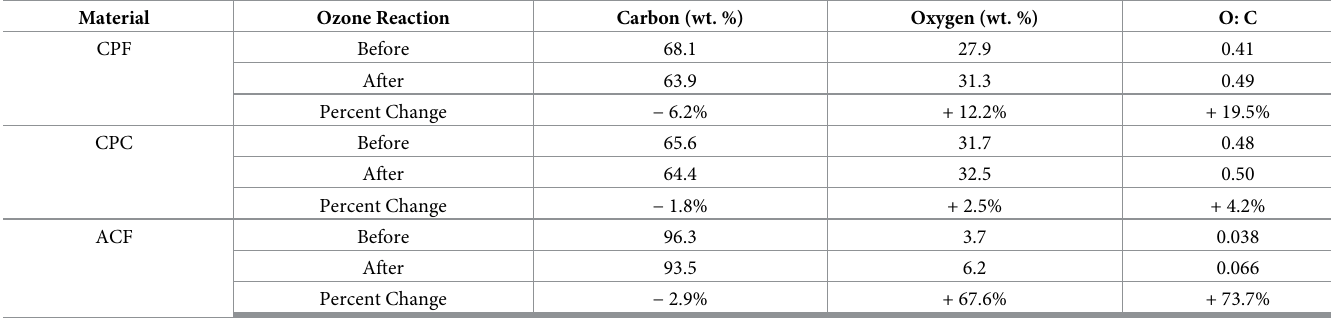
Table 3. The element analysis for solid materials under test before and after reacting with ozone. Material Ozone Reaction Carbon (wt.